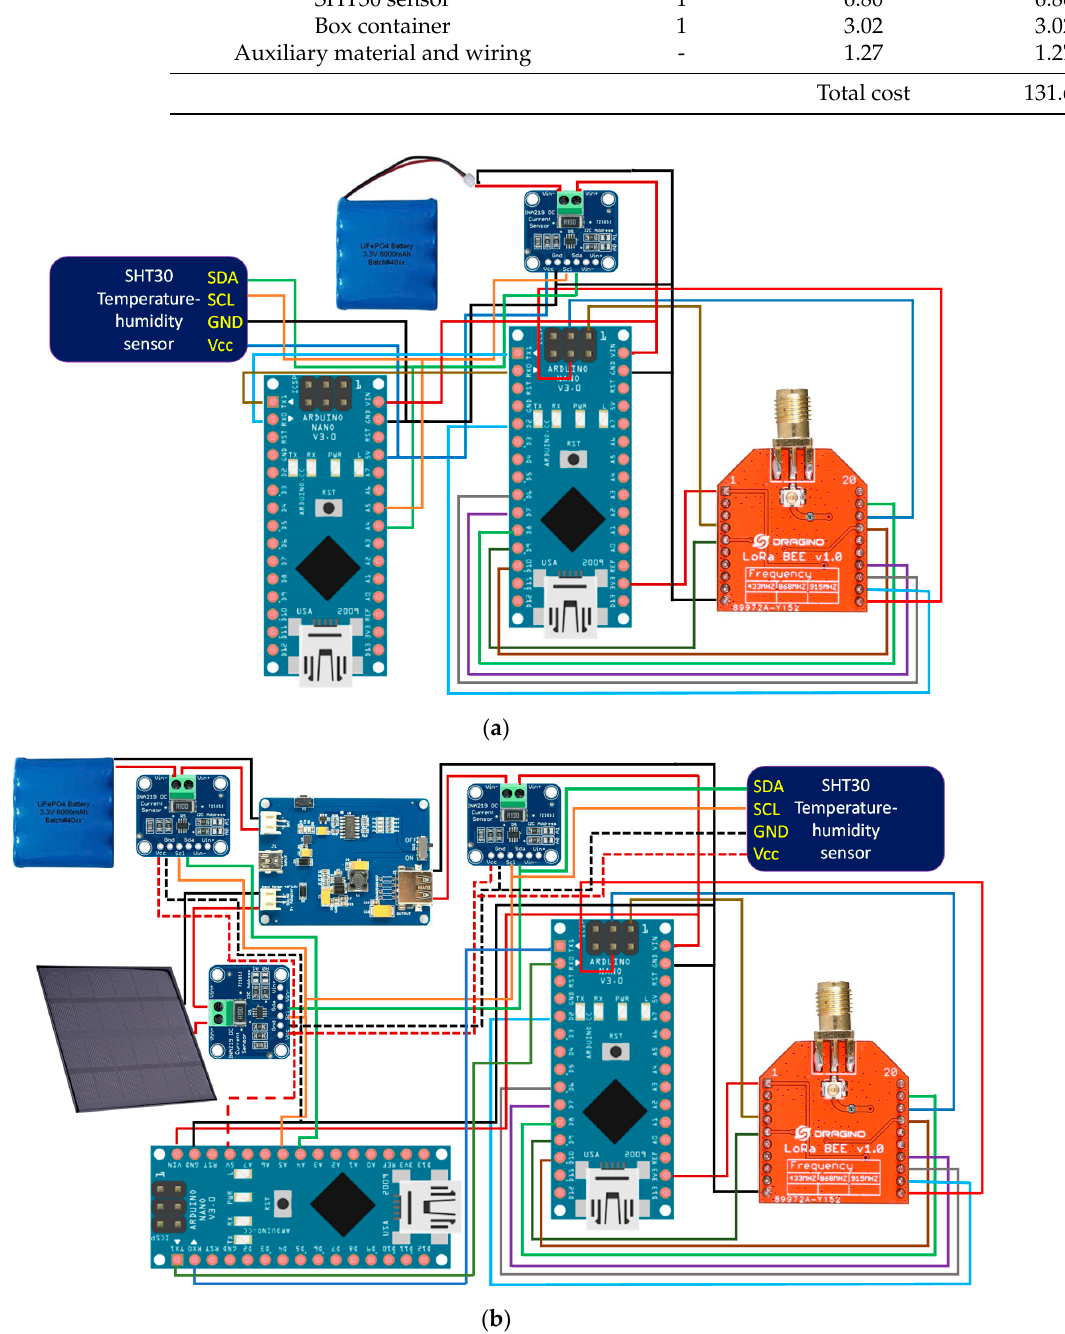
Figure 3. Wiring diagram of the THMDL: ( a ) battery power supply and ( b ) battery and solar panel power supply.